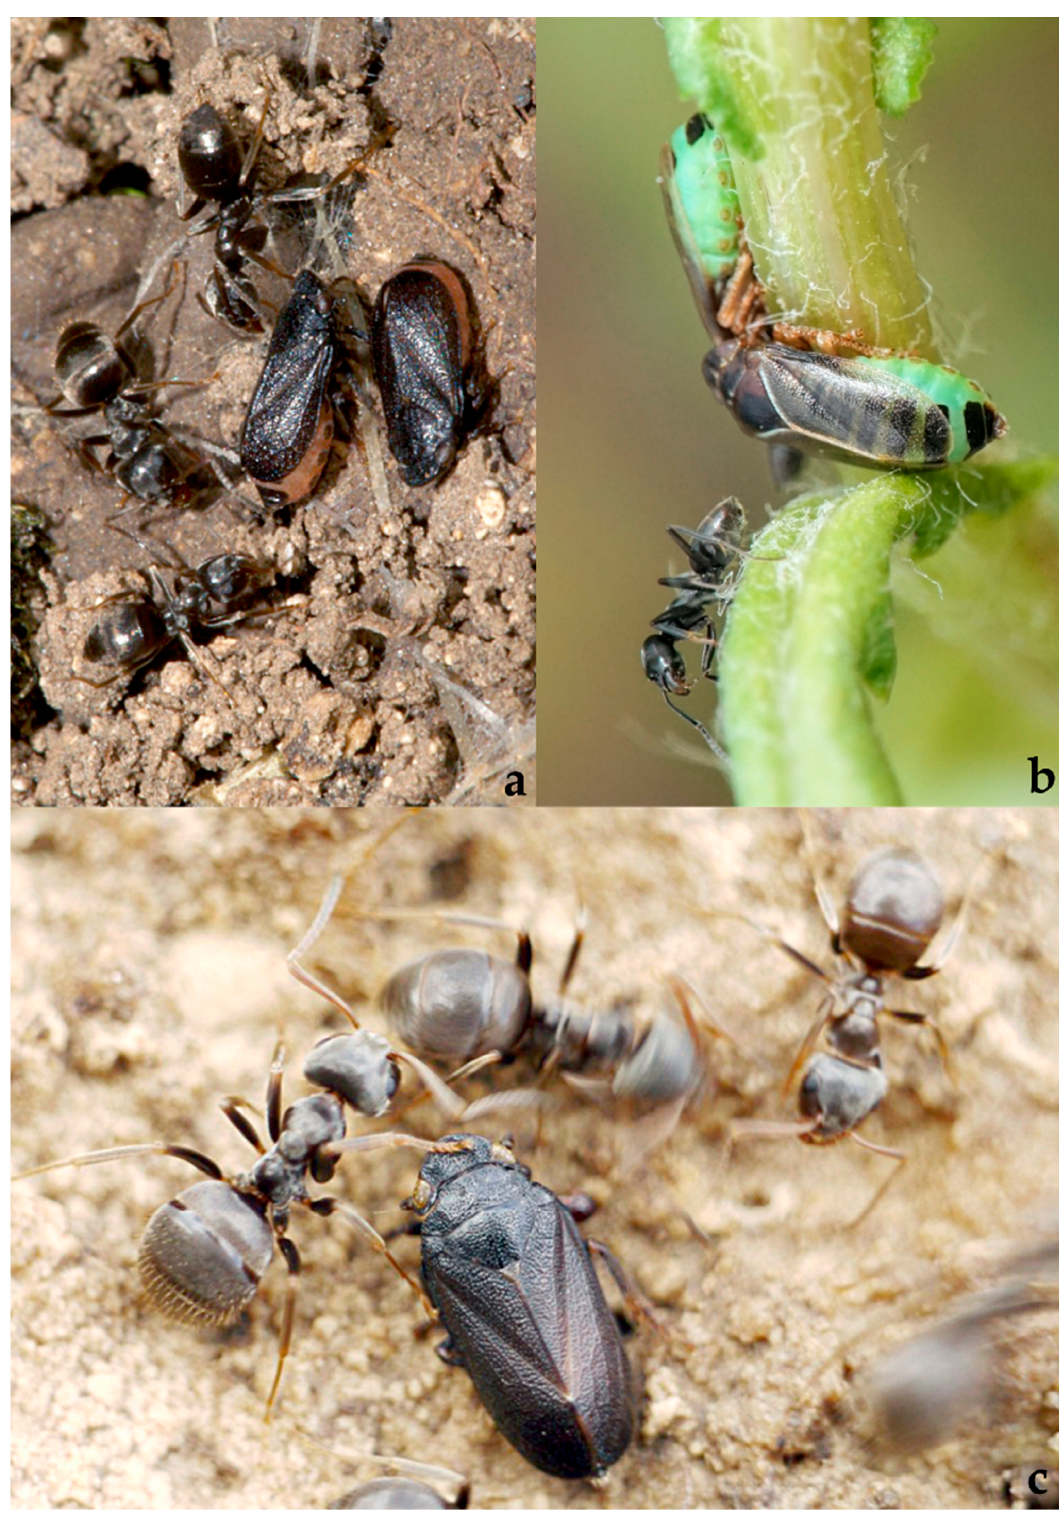
Figure 28. Tettigometridae: ( a ) Tettigometra ( Tettigometra ) atra Hagenbach, 1825 tended by Formicidae: Formicinae: Lasius platythorax Seifert, 1991, Bulgaria: Danibe plane, Rusenski Lom, 43°35 ′ 43.0 ″ N 26°06 ′ 25.0 ″ E, 24.03.2011, adults in soil ant nests under stones, obs. I. Gjonov, A. Lapeva-Gjonova; ( b ) T. ( Tettigometra ) brachycephala Fieber, 1865 tended by Formicidae: Dolichoderinae: Tapinoma sp., Croatia: Mravince, 43°32 ′ 24.8 ″ N 16°30 ′ 14.1 ″ E, 08.03.2021, obs. A. Gjeldum; ( c ) T. ( Tettigometra ) fusca Fieber, 1865 tended by Formicidae: Formicinae: Lasius sp., Ukraine: Mykolayiv, 46°58 ′ 30.1 ″ N 31°59 ′ 40.5 ″ E, 17.03.2019, adults, obs. Roman (efarilis).